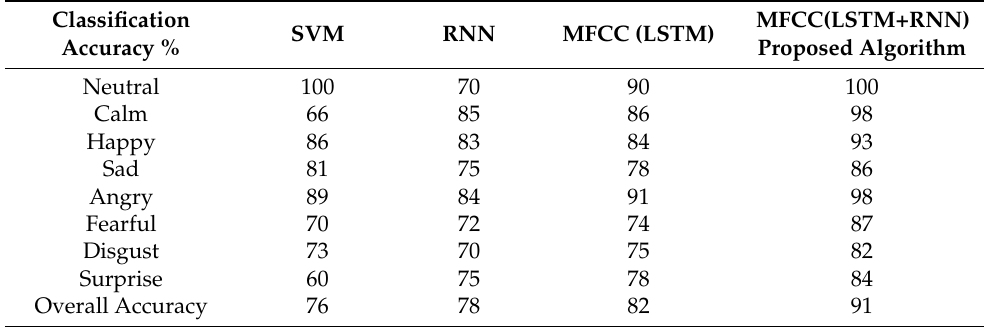
Table 6. Performance analysis of the proposed system on RAVDESS.